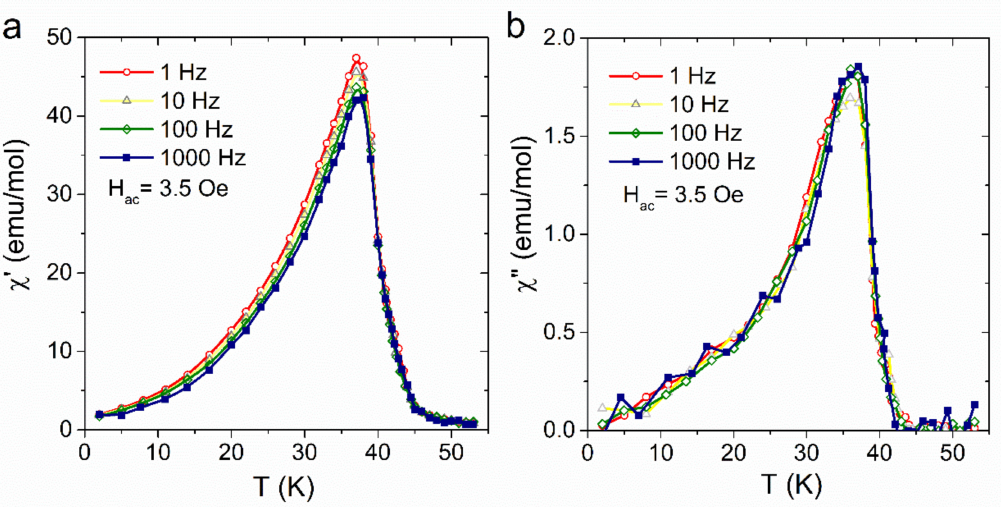
Figure 6. Temperature dependence of real ( a ) and imaginary ( b ) component of AC susceptibility of [Fe II (H 2 O) 2 ] 2 [Nb IV (CN) 8 ] · 4H 2 O